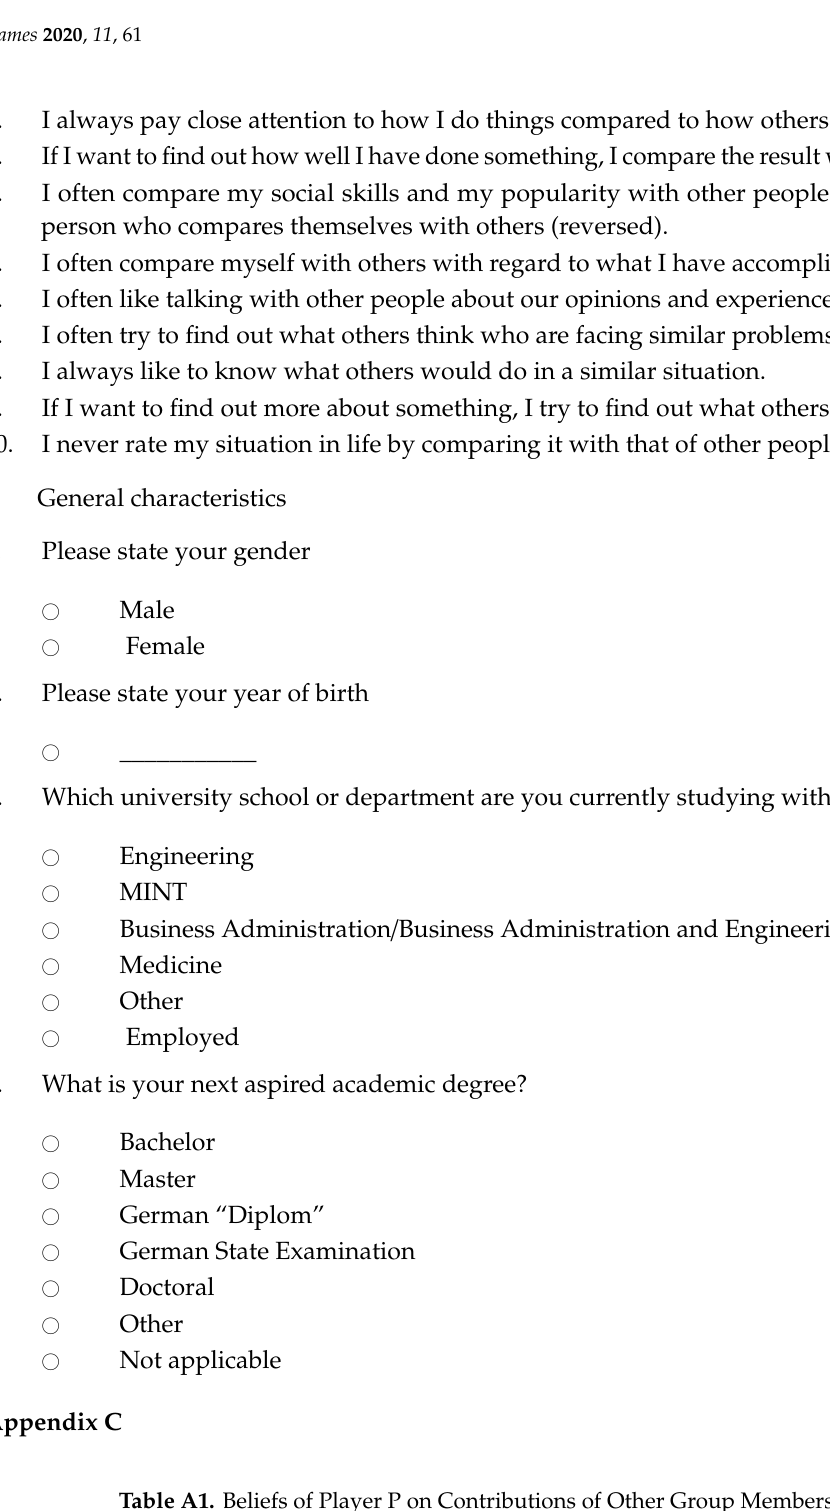
Table A1. Beliefs of Player P on Contributions of Other Group Members in Round 1. Belief